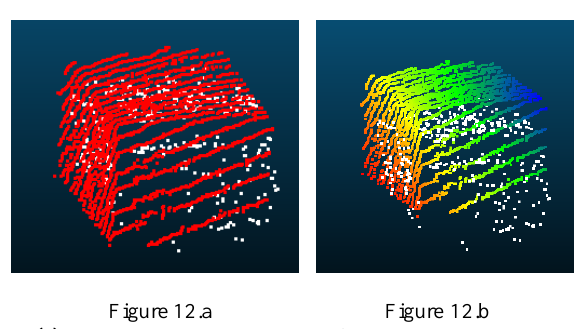
(a). The point clouds constructed from the images and the registered LIDAR using the estimated calibration parameters (b). The point clouds constructed from the images and the LIDAR before calibration